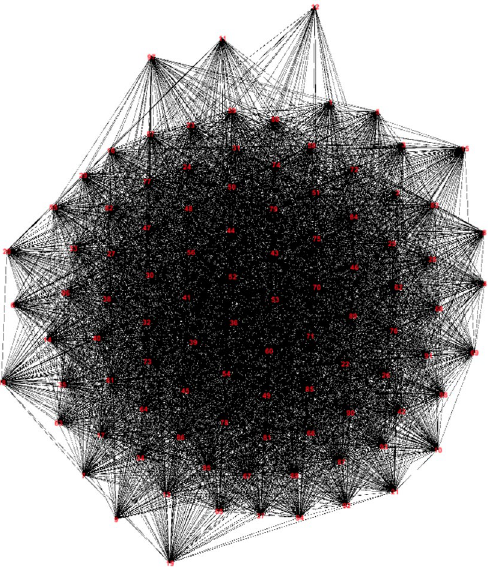
Figure 9. The constructed original graph of the Tracing Data using our model.